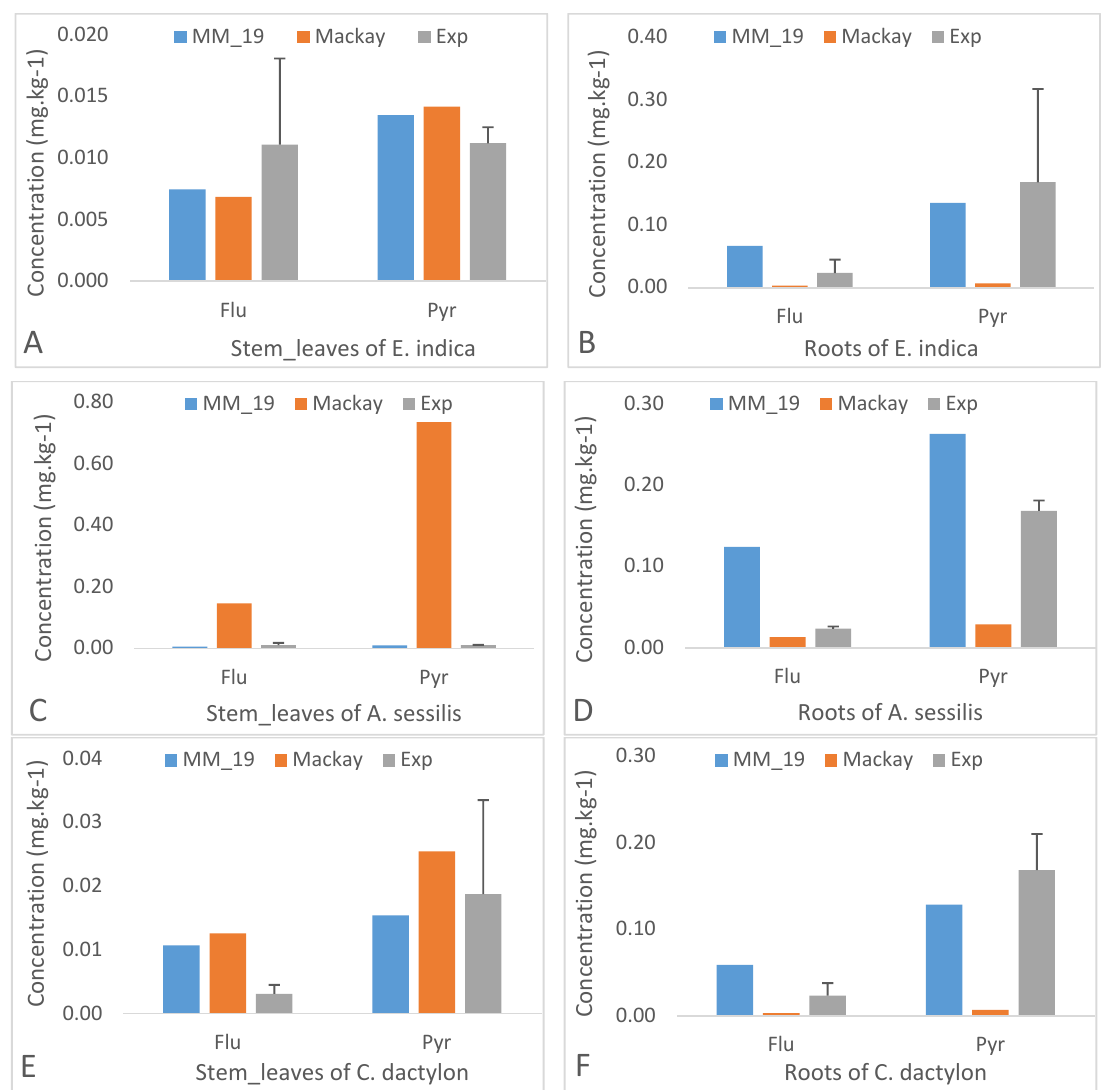
Figure 2. Improved model (MM_19), Mackay_97 model (Mackay) and experimental (Exp) concentrations of Fluoranthene (Flu) and Pyrene (Pyr) in the different parts of the 3 plant species. Stem_leaves ( A ) and Roots ( B ) of E. indica ; Stem_leaves ( C ) and Roots ( D ) of A. sessilis ; Stem_leaves ( E ) and Roots ( F ) of C. dactylon .